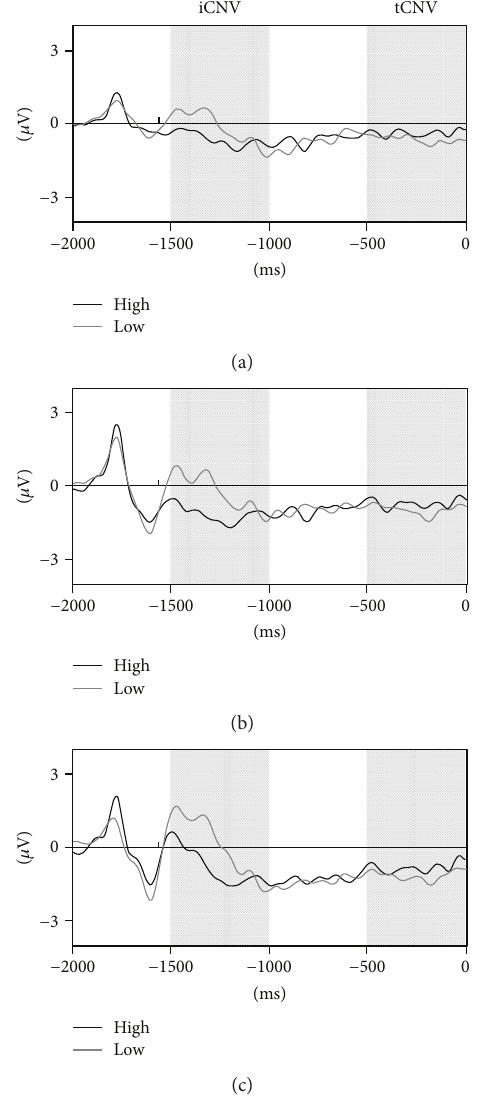
Figure 1: Grand averaged event-related potential waveforms at Fz (a), FCz (b), and Cz (c) within the latency range from S1 o ff set ( − 2000ms) to S2 onset (0 ms) displayed for adolescents with low and high motor competencies. Note: the vertical bars indicate the iCNV and the